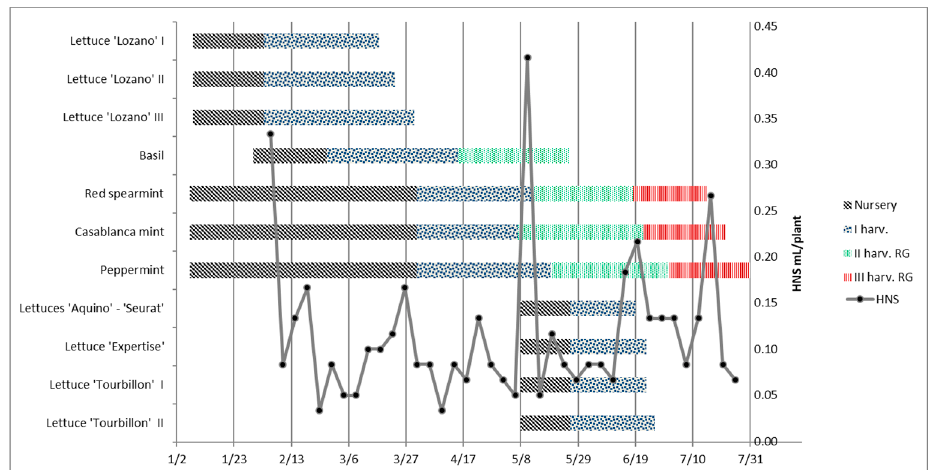
Figure 5. Growing cycle of the leafy vegetables and culinary herbs tested during the experimental period. The bars with black diagonal lines indicate the nursery stage. The bars with blue squares indicate the NGS ® growing cycle-I harvest. The bars with green points indicate the NGS ® growing cycle-II harvest, regrowth (RG). The bar with red vertical lines indicates the NGS ® growing cycle-III harvest, RG. The grey line represents the HNS flow per plant added to the system during the growing period (HNS mL/plant, indicated by the axis in the right).